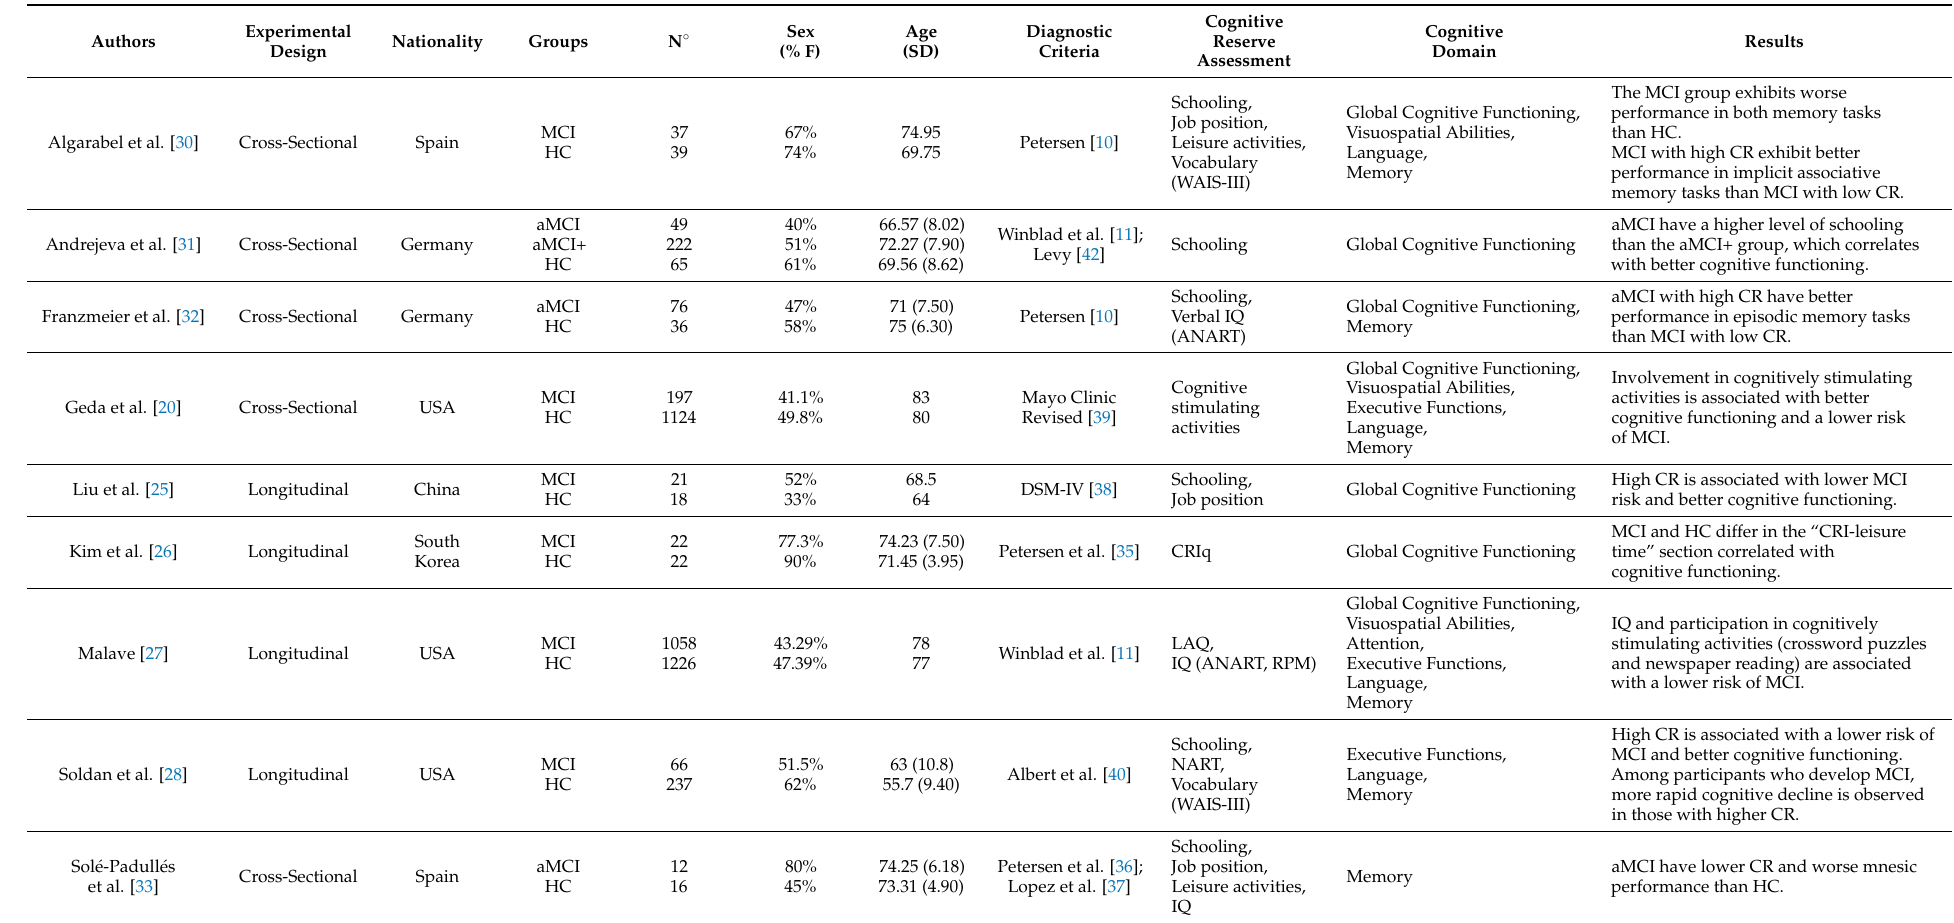
Table 6. Results of Selected